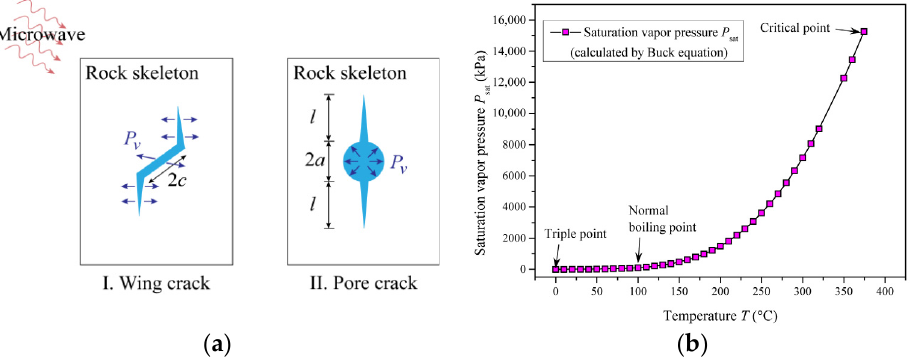
Figure 24. Two types of crack mode ( a ) and the variation of saturation vapor pressure with increasing temperature ( b ).